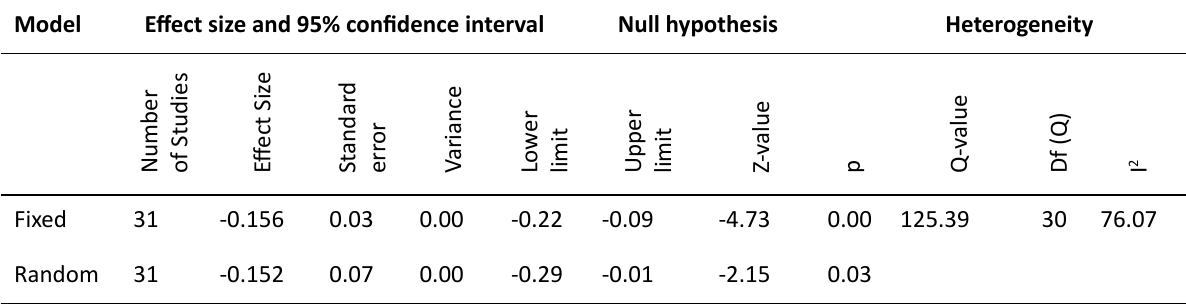
Table 2. Combined findings according to fixed and random effects model and homogeneity test